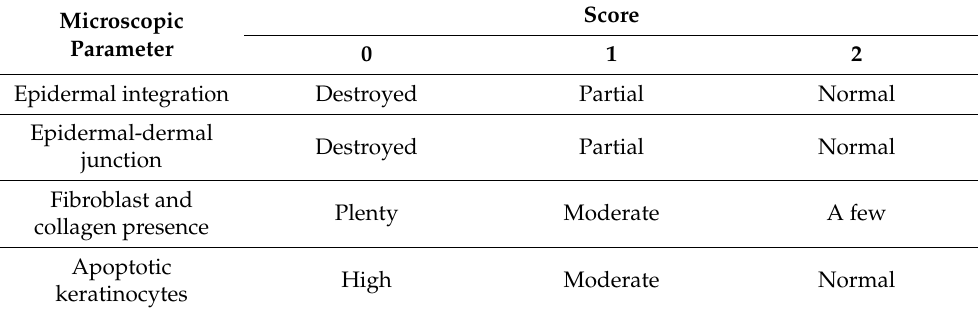
Table 1. Parameters for microscopic assessment of skin